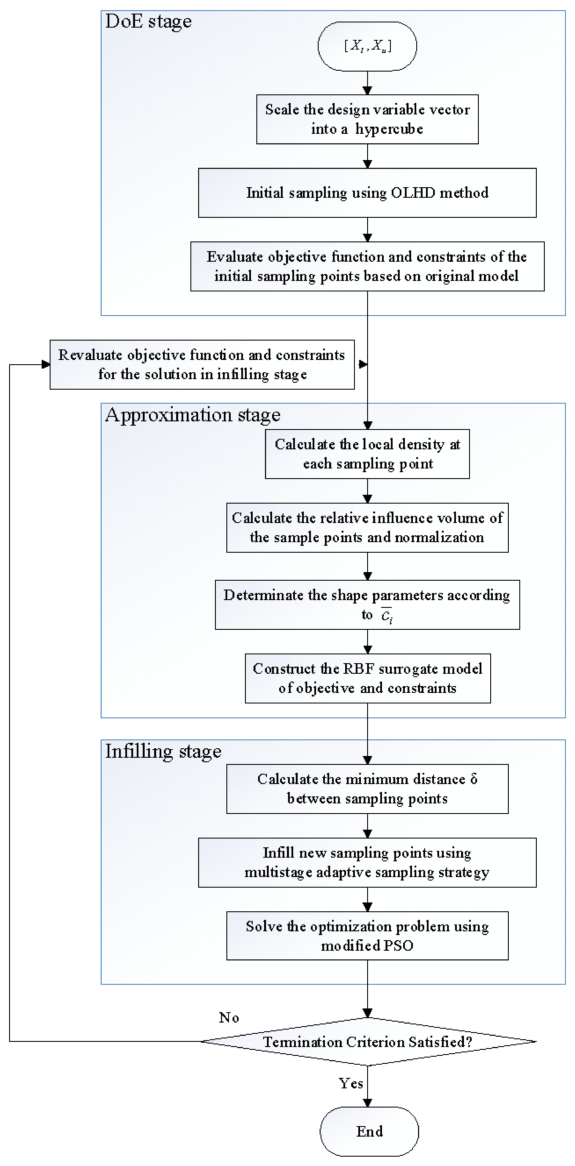
Figure 6. Procedure of improved surrogate-based optimization